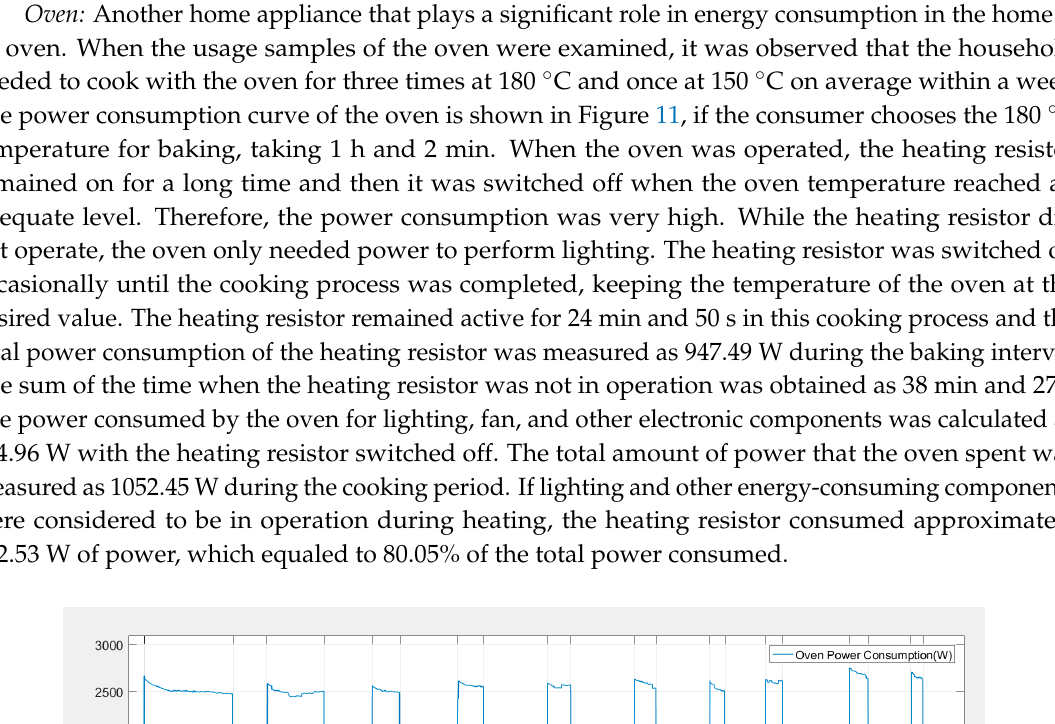
Figure 12. The power consumption curve for one ironing period in the operating mode level 2. Hair Dryer: The other selected device was a hair dryer. The power consumption data belonging to the hair dryer was measured and recorded. The results of the measurements showed that the hair dryer was used for 2 min in high-speed blowing mode every day and 3 times in a week for an additional 11 min. Slow-speed blowing mode usage of the hair dryer did not present, because the users never used this mode in November 2016. If the average frequency of the usage of the hair dryer was calculated, the weekly total duration was found to be approximately 43 min. The weekly average power consumption of the hair dryer was calculated to be 1263.77 W. Figure 13 shows the power consumption curve of the hair dryer in high-speed blowing mode for one usage period.